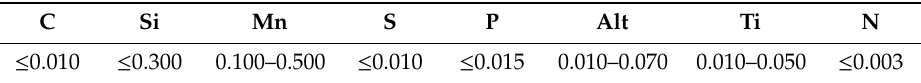
Table 1. Chemical composition of the tested steel (mass fraction,